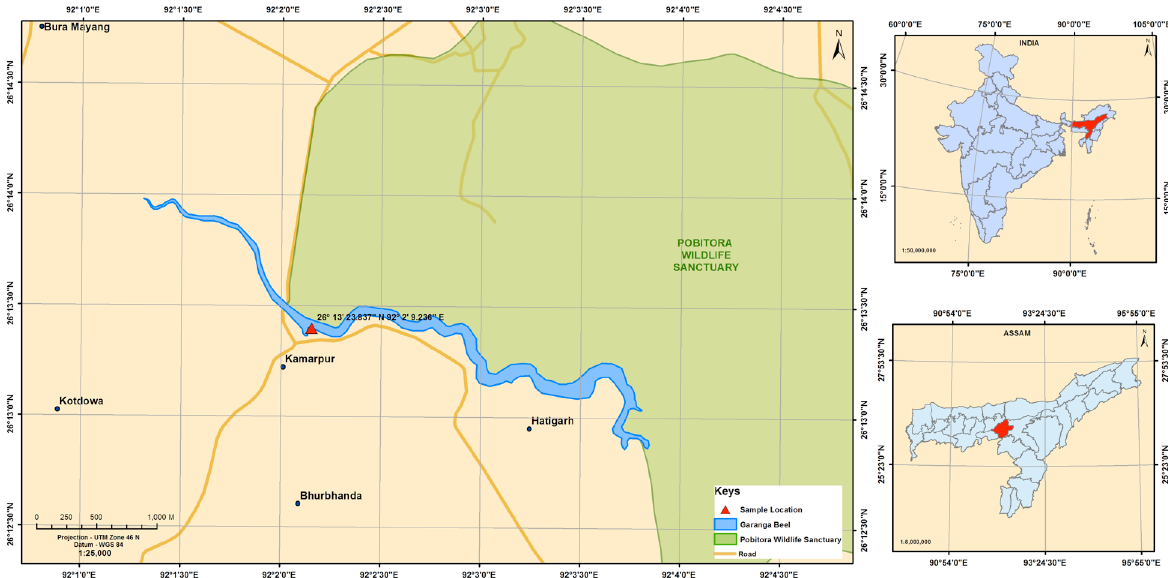
Figure 1. Map of Garanga wetland (Beel) indicating sample site (Courtesy: Research Education Working Plan, Department of Forest,